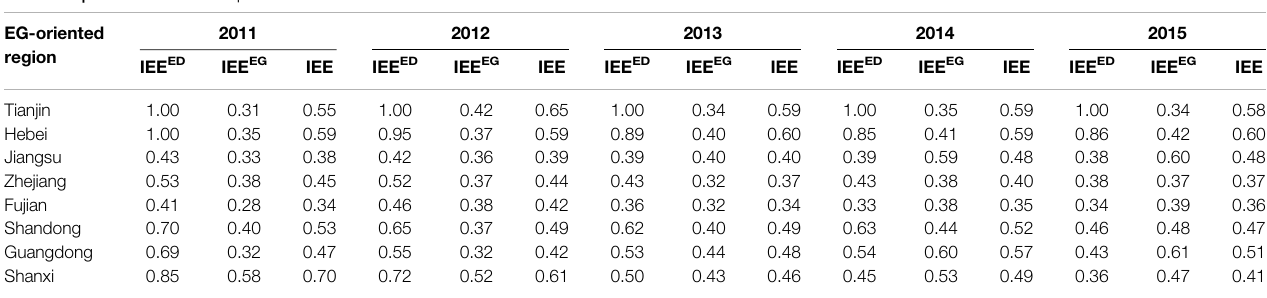
TABLE 5 | IEE of EG-oriented provinces. EG-oriented